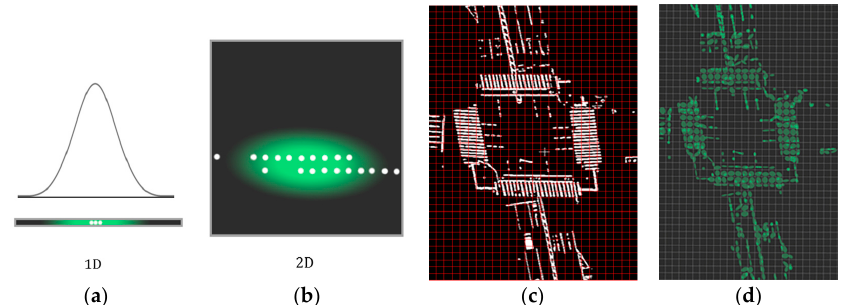
Figure 13. Generation of the Gaussian distribution from the reference data: ( a ) estimated 1D Gaussian distribution of the sample points; ( b ) estimated 2D Gaussian distribution of the sample points; ( c ) extracted aerial road markings; and ( b ) generated NDT map with a 2 m grid size.